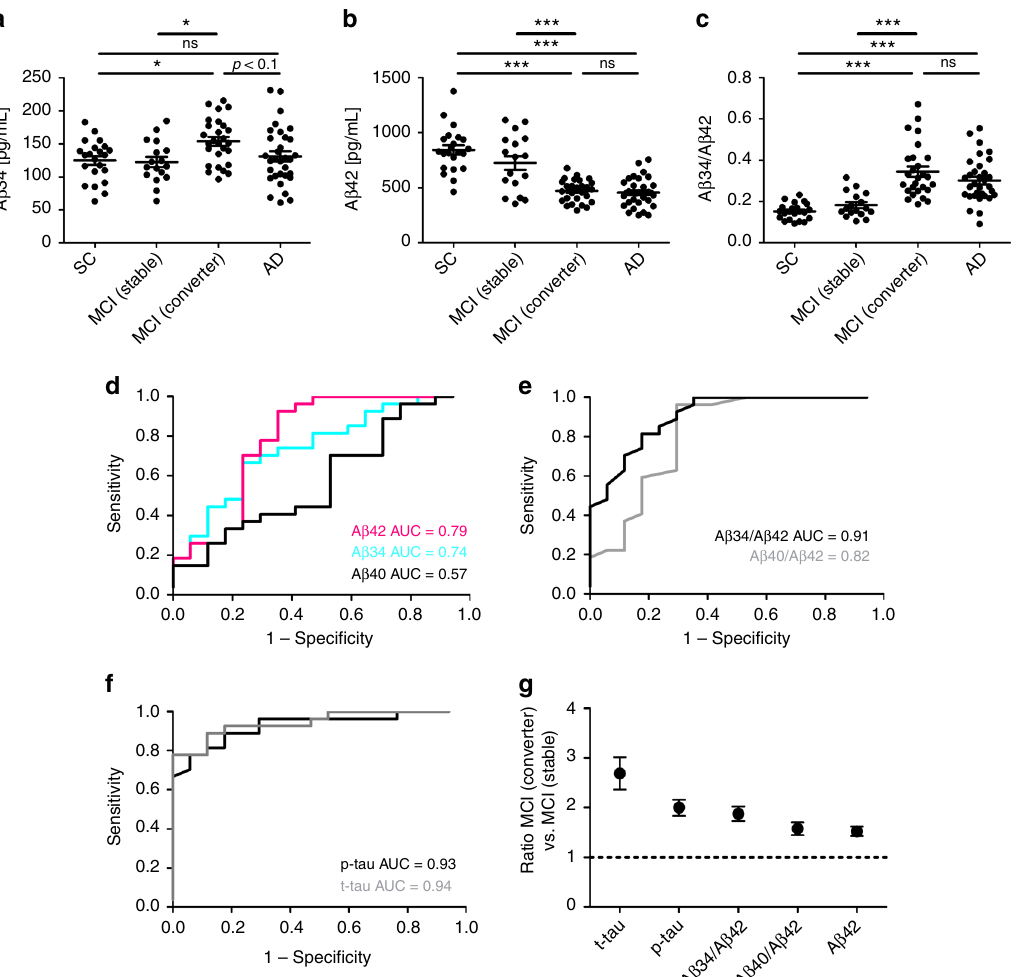
Fig. 6 A β 34 and core biomarkers in the Amsterdam Dementia Cohort. a – c Analyses of A β 34 and A β 42 in human CSF samples. n = 22 subjective complaints (SC), n = 17 MCI (stable), n = 27 MCI (converter), n = 32 Alzheimer ’ s disease (AD). Horizontal lines indicate mean ± s.e.m. The data were analyzed with one-way ANOVAs and Tukey ’ s post-hoc tests (*** p < 0.001, * p < 0.05, ns p > 0.05). a A β 34, one-way ANOVA F (3, 94) = 3.71, p < 0.05, b A β 42, one-way ANOVA F (3, 94) = 30.91, p < 0.0001, c A β 34/A β 42, one-way ANOVA F (3, 94) = 21.71, p < 0.0001. d Receiver operating characteristic (ROC) curves were computed on CSF levels of A β 34, A β 40, and A β 42 in samples from the Amsterdam Dementia Cohort n = 17 MCI (stable), n = 27 MCI (converter). e ROC curves on A β 40/A β 42 and A β 34/A β 42 ratios from MCI (stable) and MCI (converter)). ROCs were compared using DeLong test: various molecules measured in CSF, which is based on average MCI (converter) to MCI (stable) ratios in the Amsterdam Dementia Cohort. The MCI (converter) to MCI (stable) ratio of A β 42 was inverted for better comparison with the other